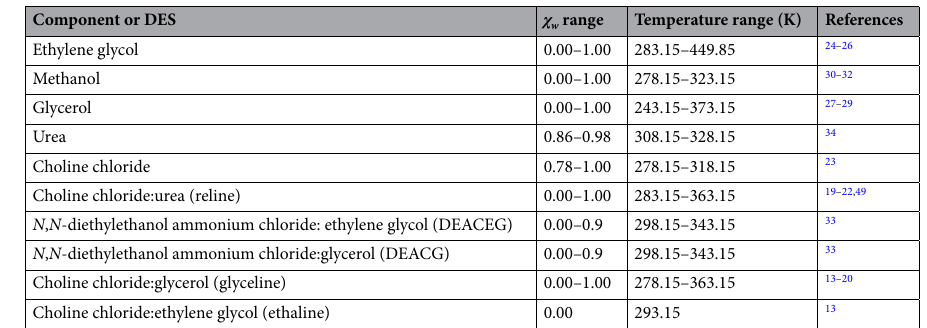
Table 1. Ranges of χ w and temperature for viscosities of 10 aqueous mixtures as collected from